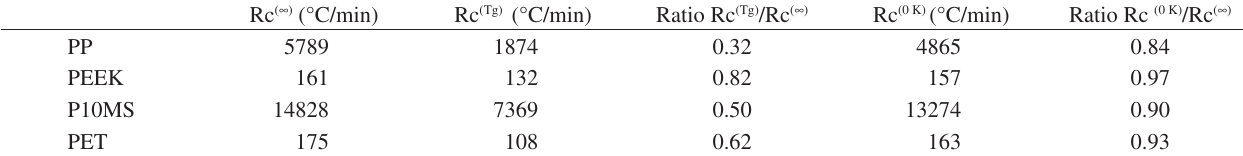
Table 4. Critical cooling rates obtained for PP, PEEK, P10MS and PET by the original Barandiarán and Colmenero method, Rc ( ∞ ) , and by the Modified Baran- diarán and Colmenero methods, Rc (Tg) and Rc (0K) .